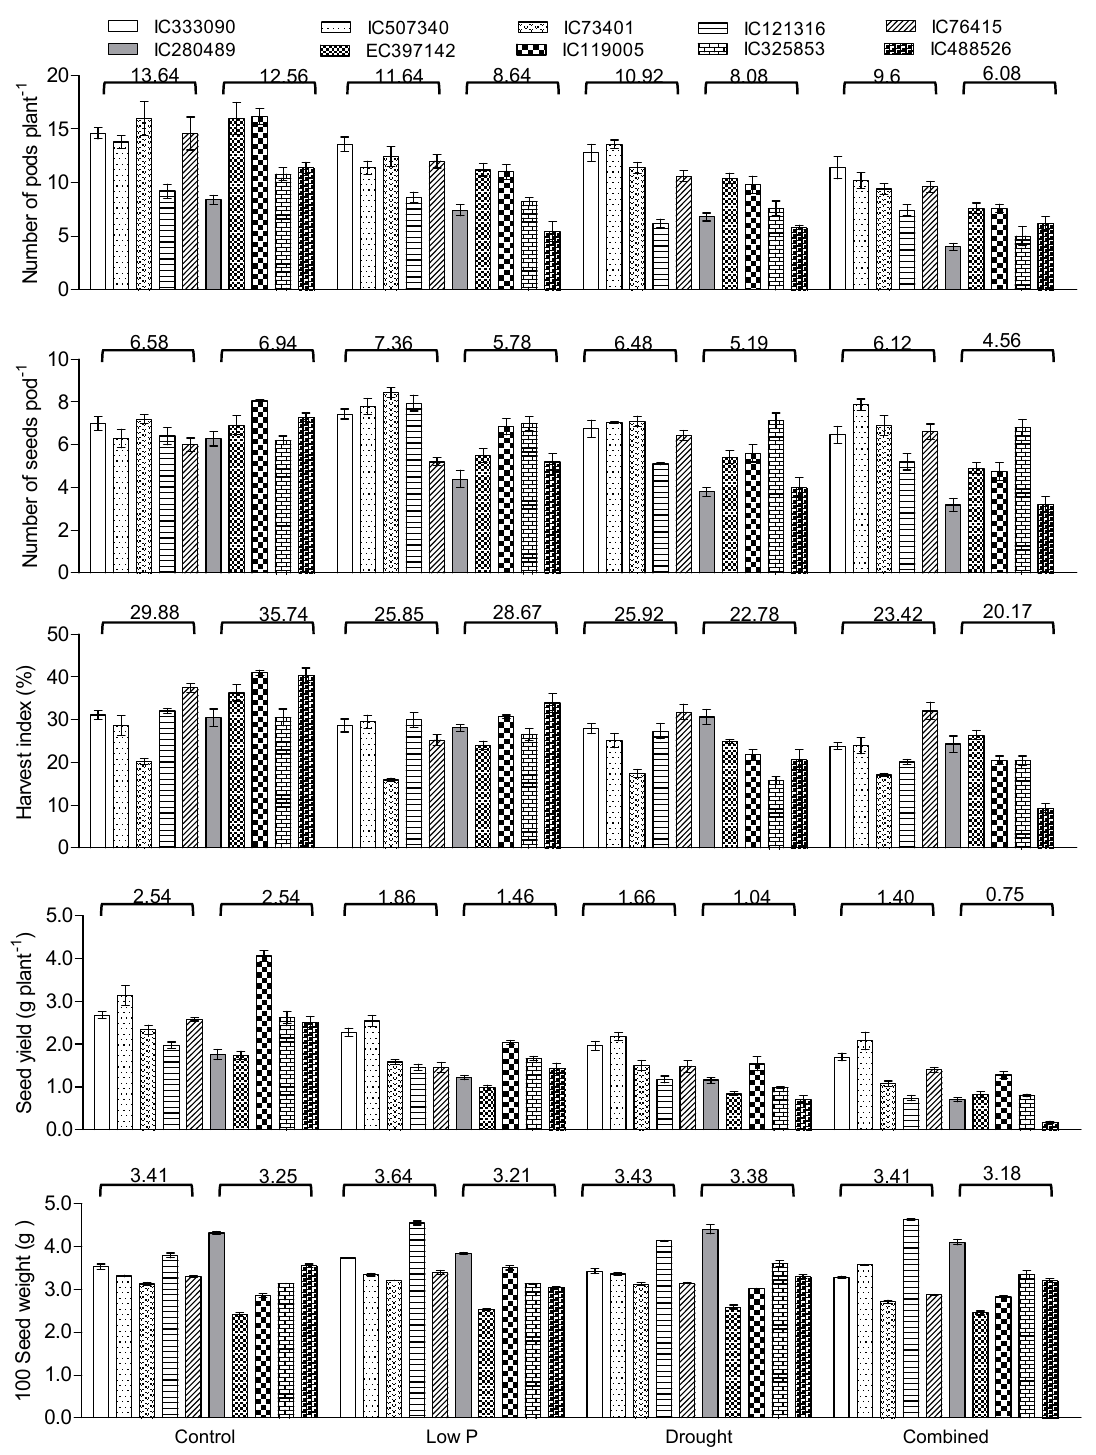
Figure 6. Effect of low P, drought, and combined stress on yield traits in 10 mung bean accessions. Values on bars 1–5 and 6–10 represents mean of tolerant and sensitive accessions, respectively. The letters on each bar denotes significant differ- ence between accessions in each treatment. Error bars indicate mean ± SEm.